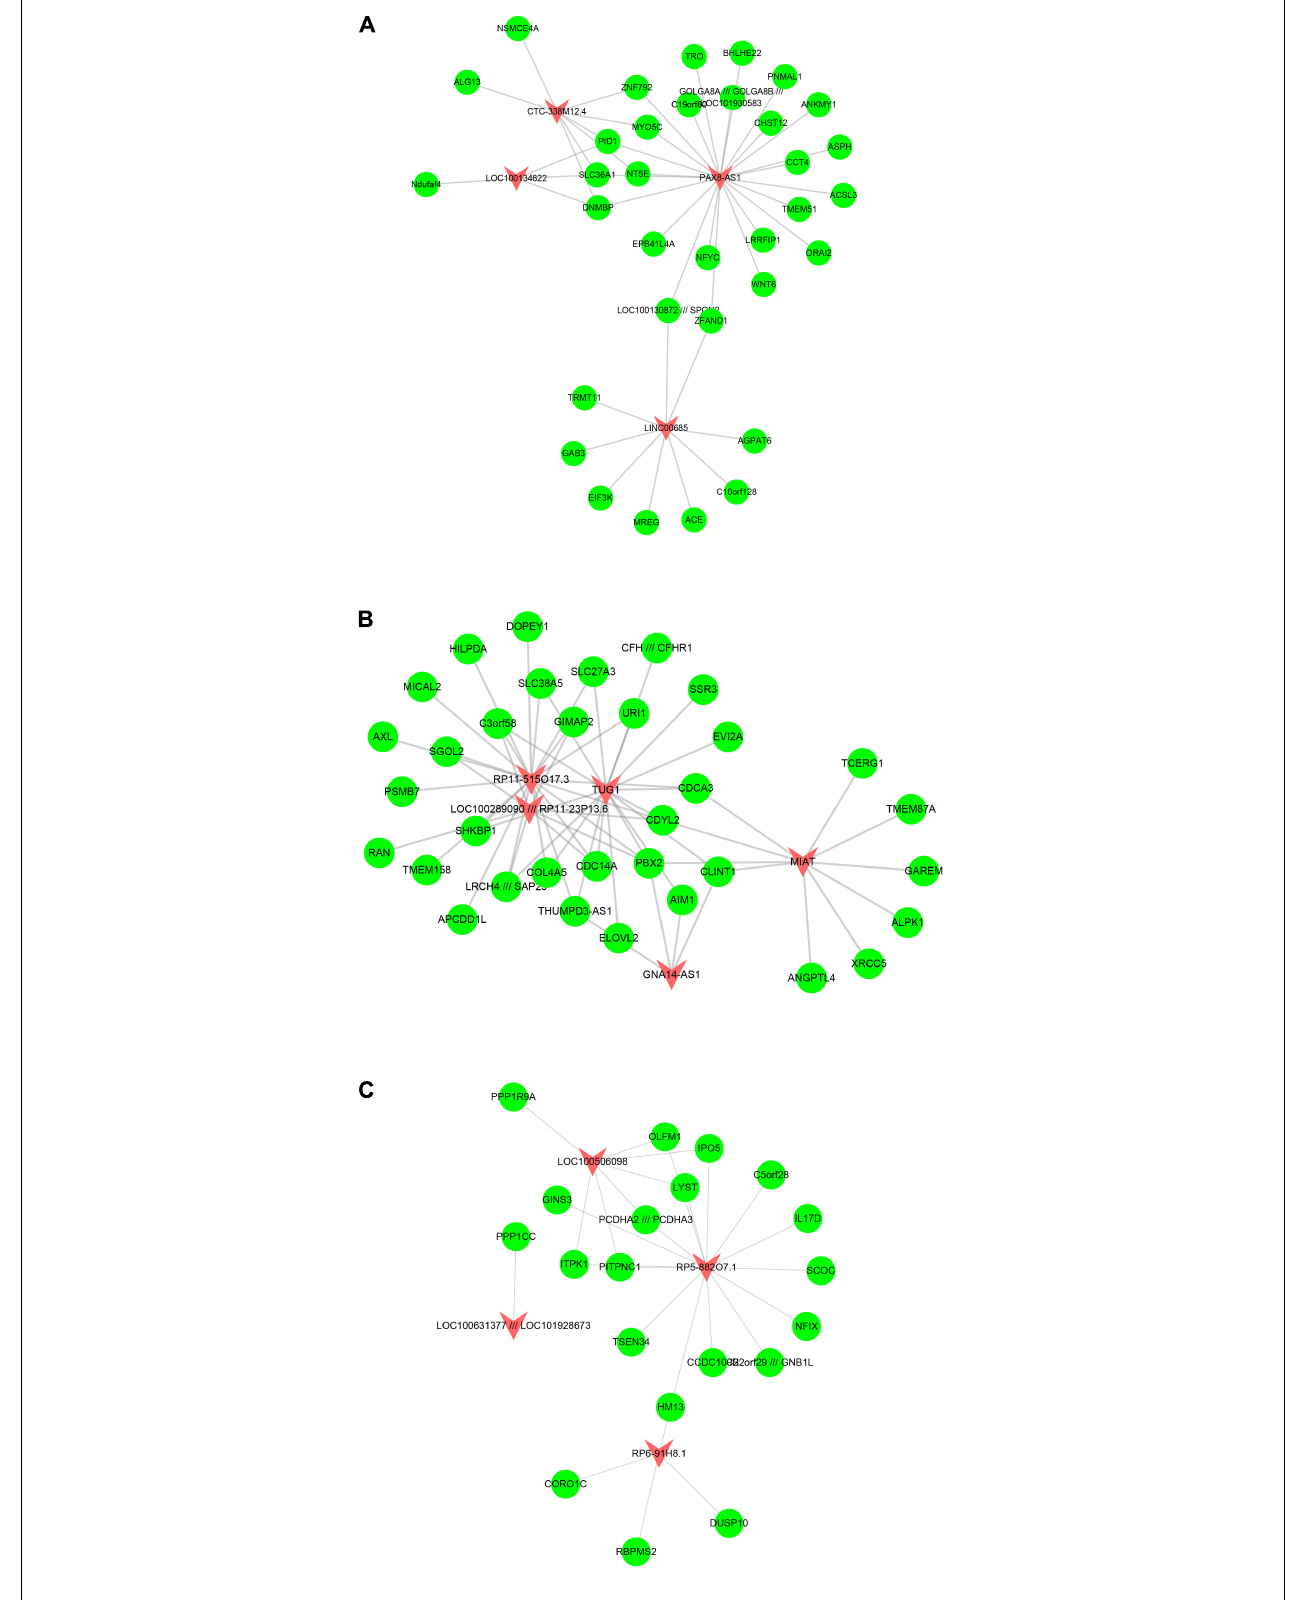
FIGURE 5 | Result of atherosclerosis related lncRNA-mRNA co-expression networks. Construction of module 13–15 lncRNA-mRNA co-expression networks based on WCGNA analysis. The co-expression networks of module 13 (A) , module 14 (B) , and module 15 (C) .